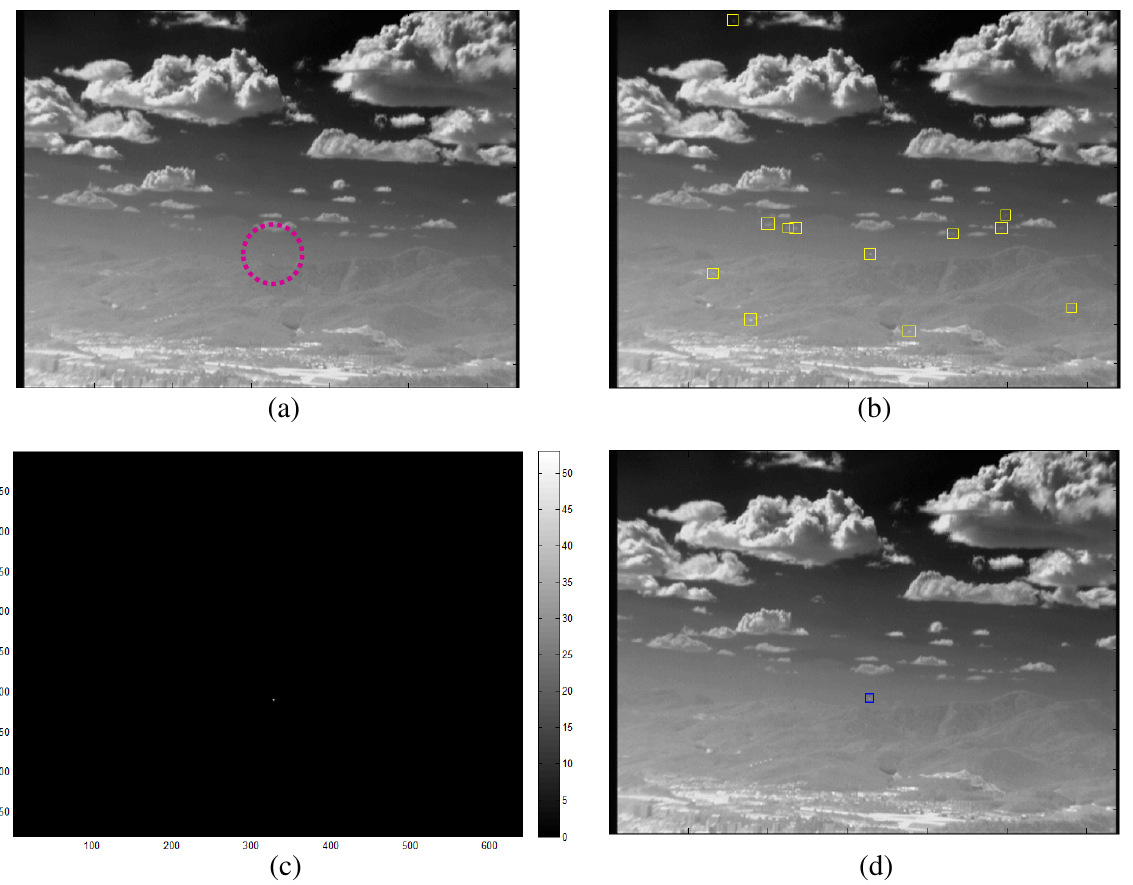
Figure 15. Example of a sub-pixel velocity target candidate detector: ( a ) incoming target (elevation angle: 2 ◦ , yaw angle: 1 ◦ ); ( b ) M-MSF-based target candidate regions; ( c ) T CF results; ( d ) results of the proposed sub-pixel velocity target detector.